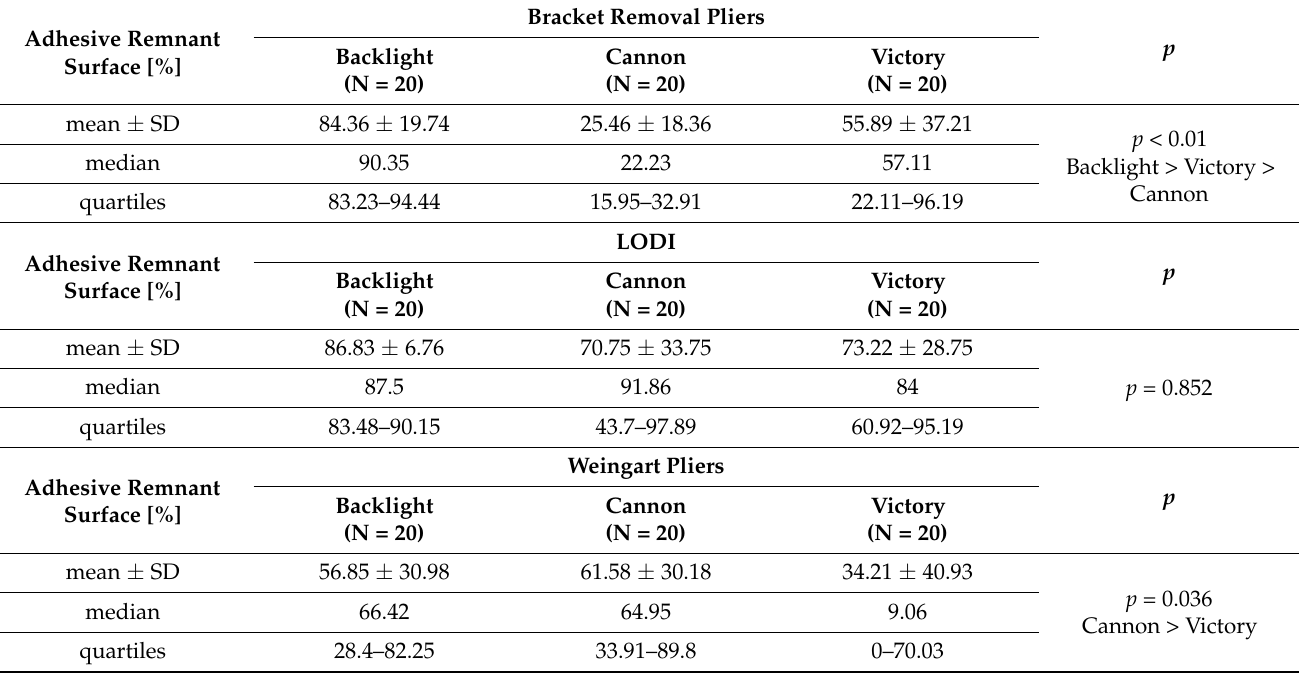
Table 3. Comparison of the amount of adhesive remaining on the enamel after debonding according to the type of bracket